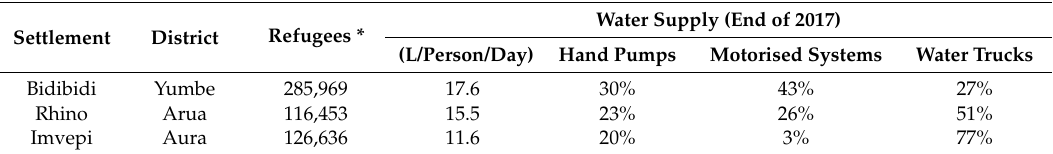
Table 1. Number of refugees and access to water in Bidibidi, Rhino and Imvepi settlements in the north-western region of Uganda *